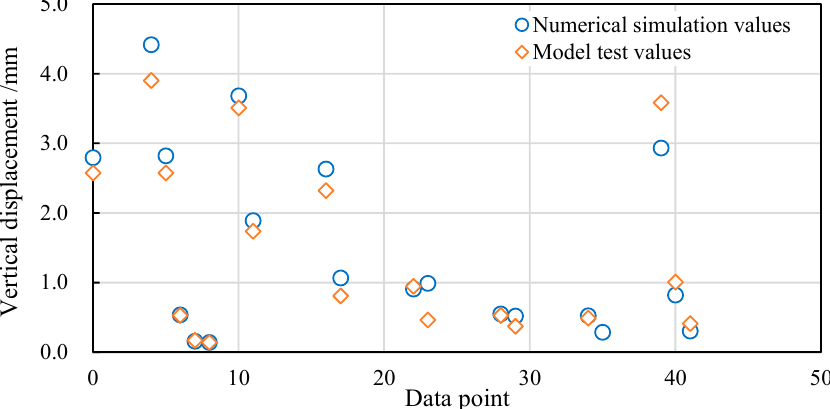
Figure 17. The vertical displacement cloud picture (0.557 kN): ( a ) numerical simulation; ( b ) model test.